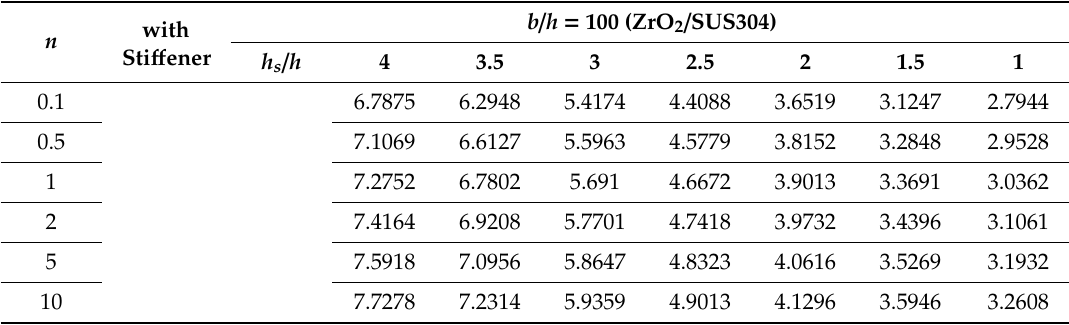
Table 11. Buckling coe ffi cient of FGM plate with and without a central sti ff ener (ZrO2 / SUS304, b / h = 100).